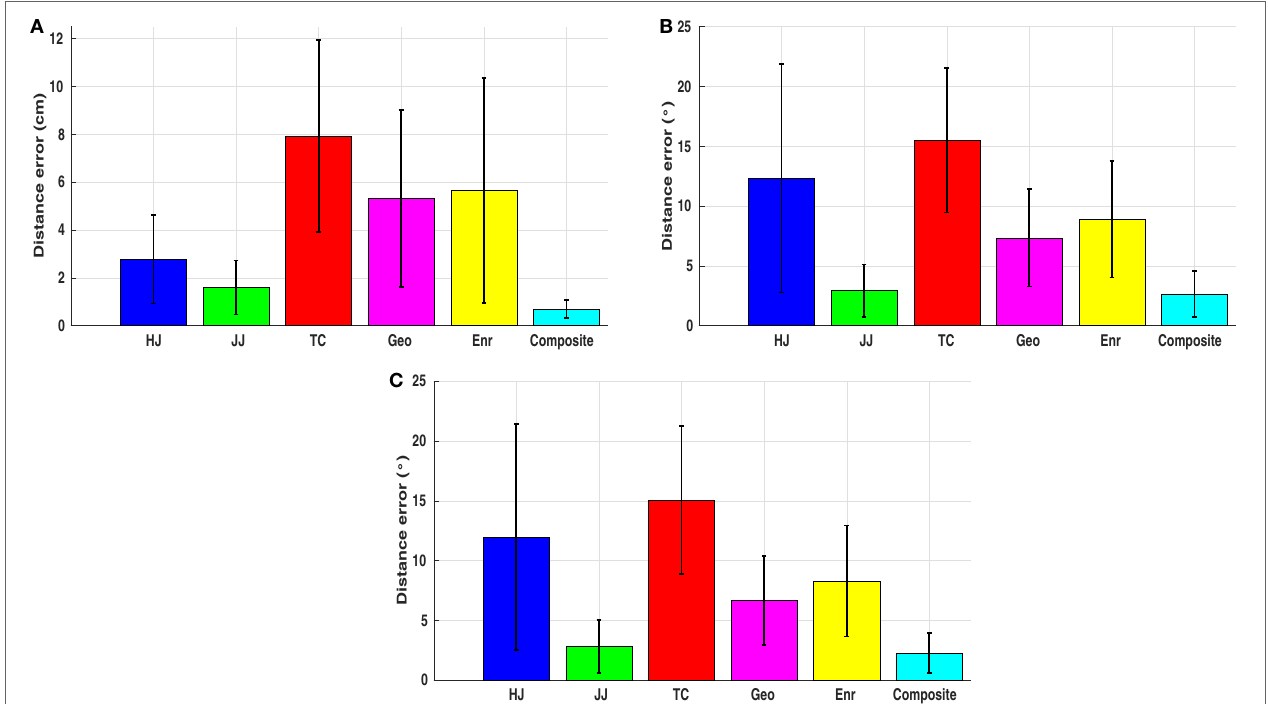
FIGURE 6 | Average distance error over all reaching tasks. HJ, JJ, TC, Geo, Enr, and Composite are the hand jerk, the joint angle jerk, the torque change, the geodesic, the energy, and the composite cost function, respectively. Mean values and the SDs of the errors for each cost function are presented. (A) Distance error measured by comparing the end-effector trajectories. (B,C) Distance error measured by comparing the joint angle trajectories with and without considering target one.